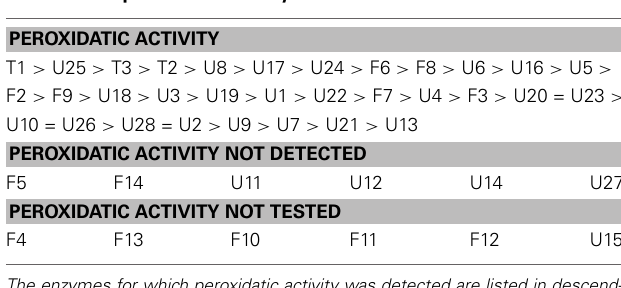
Table 3 | Arabidopsis recombinant glutathione S -transferases